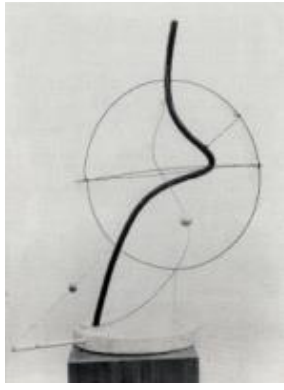
Figure 5. A Universe , by Alexander Calder, 1934. Pipe, motor, wire, wood and string, 103 × 76 cm. Museum of Modern Art , New